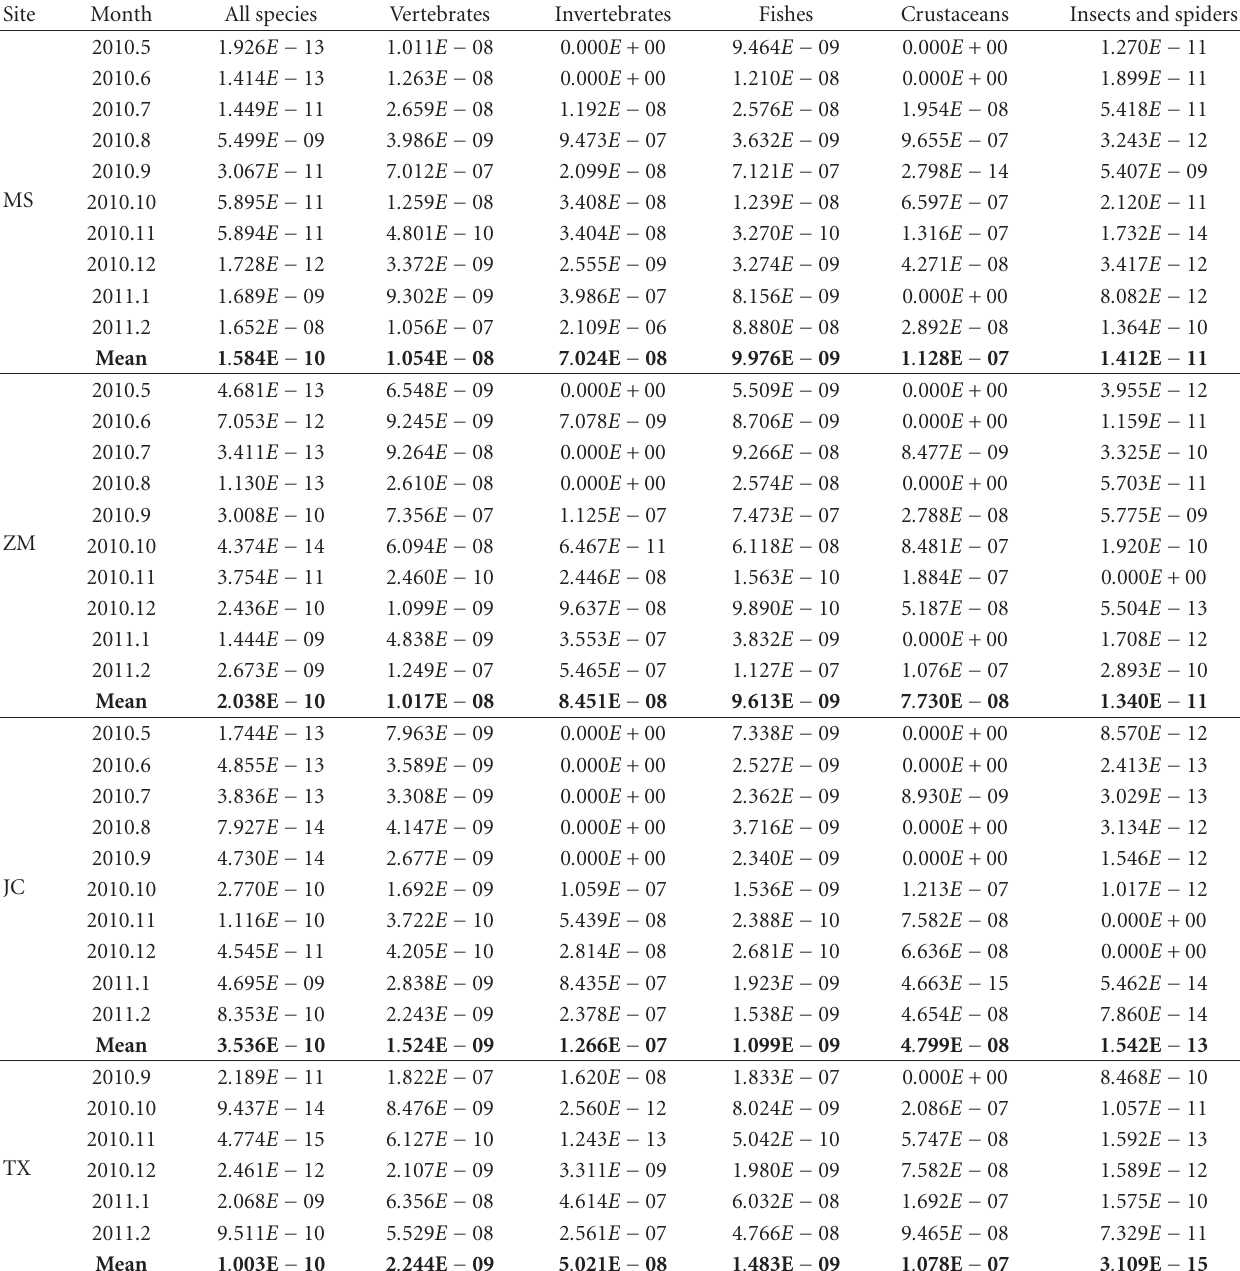
Table 8: The spatial and temporary variation of combining ecological risks